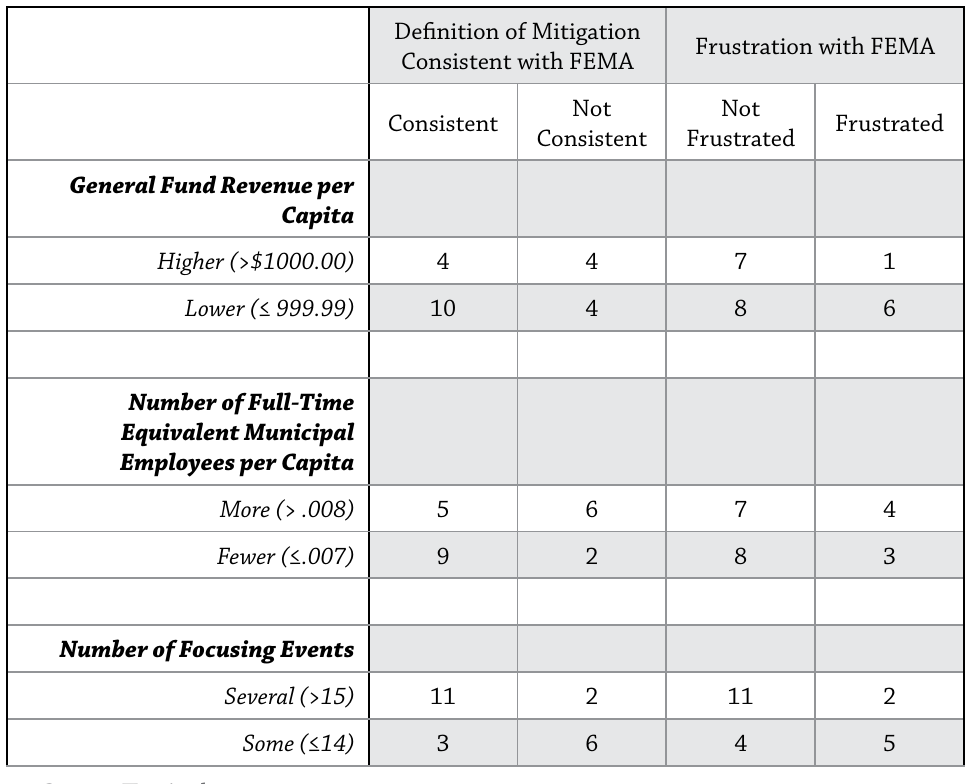
Definition of Mitigation Frustration with FEMA Consistent with FEMA Not Not Consistent Frustrated Consistent Frustrated